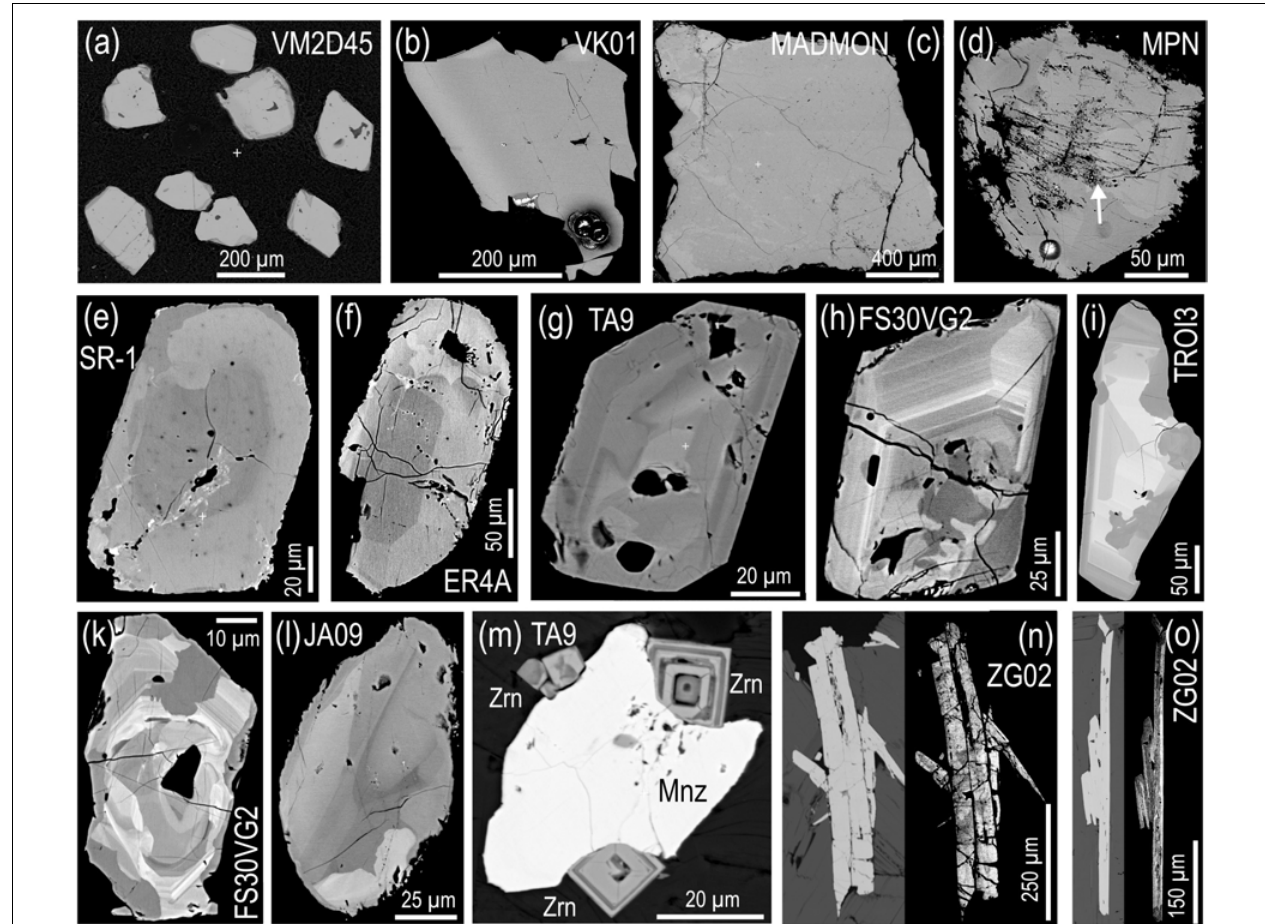
FIGURE 2 | Monazite in peraluminous granite and pegmatite. (a) Euhedral monazite from a granite in a grain mount, distributed as a reference material for EPMA Th-U-Pb age dating by BRGM Orléans. (b) Inclusion-free monazite with perfect homogeneous distribution of Th from a granite, used as reference material for U-Pb SHRIMP monazite dating. (c) Reference monazite from a Madagascar pegmatite, with cracks separating homogeneous domains (Schulz and Schüssler, 2013). (d) Reference monazite with sutured grain boundary, numerous cracks and domains of alteration (arrow), used as reference material for SHRIMP U-Pb monazite dating. (e,f) Euhedral large monazite with cracks and zoned distribution of Th in Erinpura granitoid (Just et al., 2010). (g) Euhedral zoned monazite from a Pan-African two-mica granite (Djouka-Fonkwe et al., 2008). (h,i) Monazite with symmetric zonation of the margin and amoeboid distribution of Th in the core, from Mittweida granite and Troischau granite dike, Saxonian Granulite Massif. (k) Monazite with cloudy or amoeboid internal distribution of Th from Mittweida granite. (l) Paleoproterozoic monazite with embayment of a Th-rich marginal zone from a granite in the Ntem Unit (Cameroon). (m) Monazite with contact to several zircon (Zrn) crystals in a Pan-African granite. (n,o) Needle-shaped euhedral monazite from the Zinnwald greisen granite